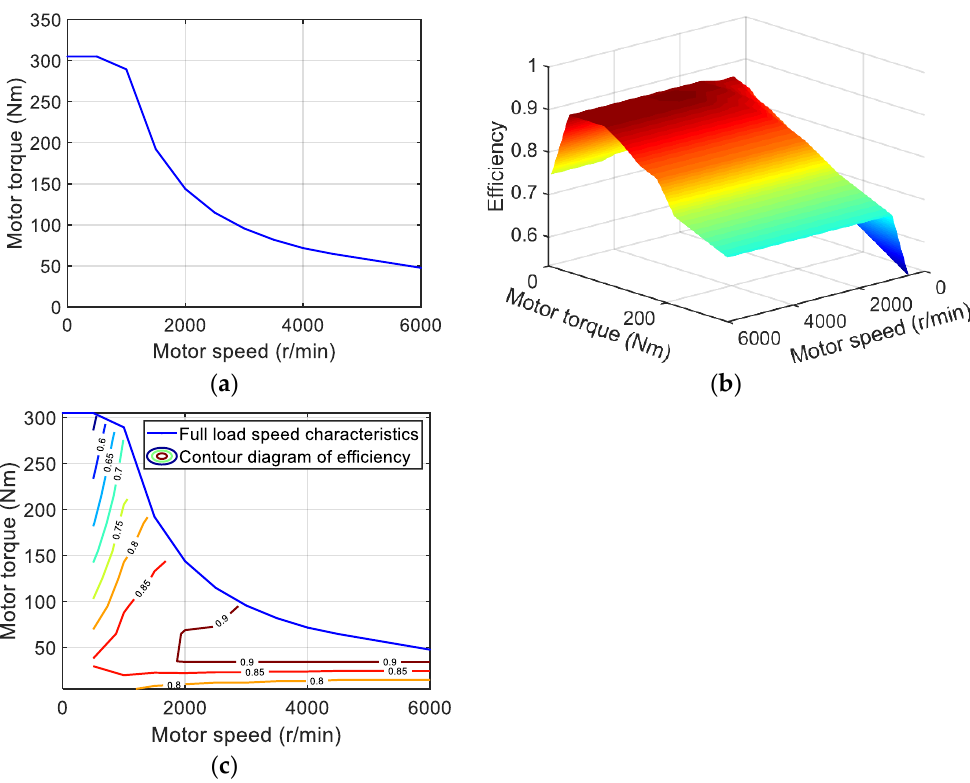
Figure 3. Characteristics of motor 2: ( a ) full load speed characteristics; ( b ) efficiency characteristics; and ( c ) contour plot of characteristics.